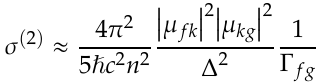
− 2 ) from the transition energies